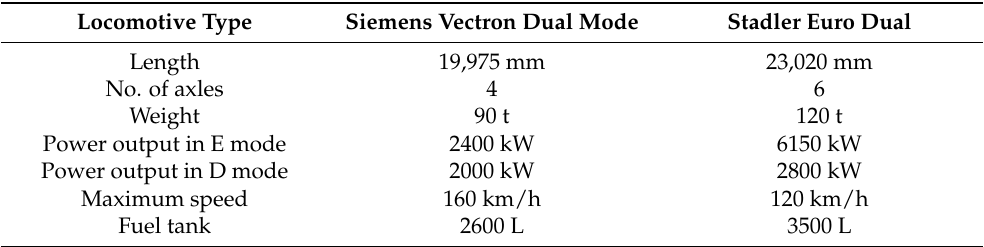
Table 4. Technical parameters of dual locomotives (E: Catenary mode, D: Off-catenary mode) Source: [20,21]. Source: